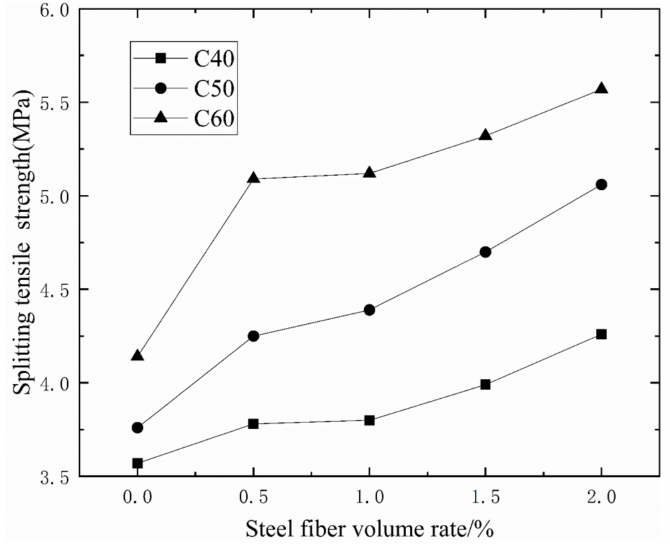
Figure 9. The relationship between the splitting tensile strength of concrete and steel fiber content.